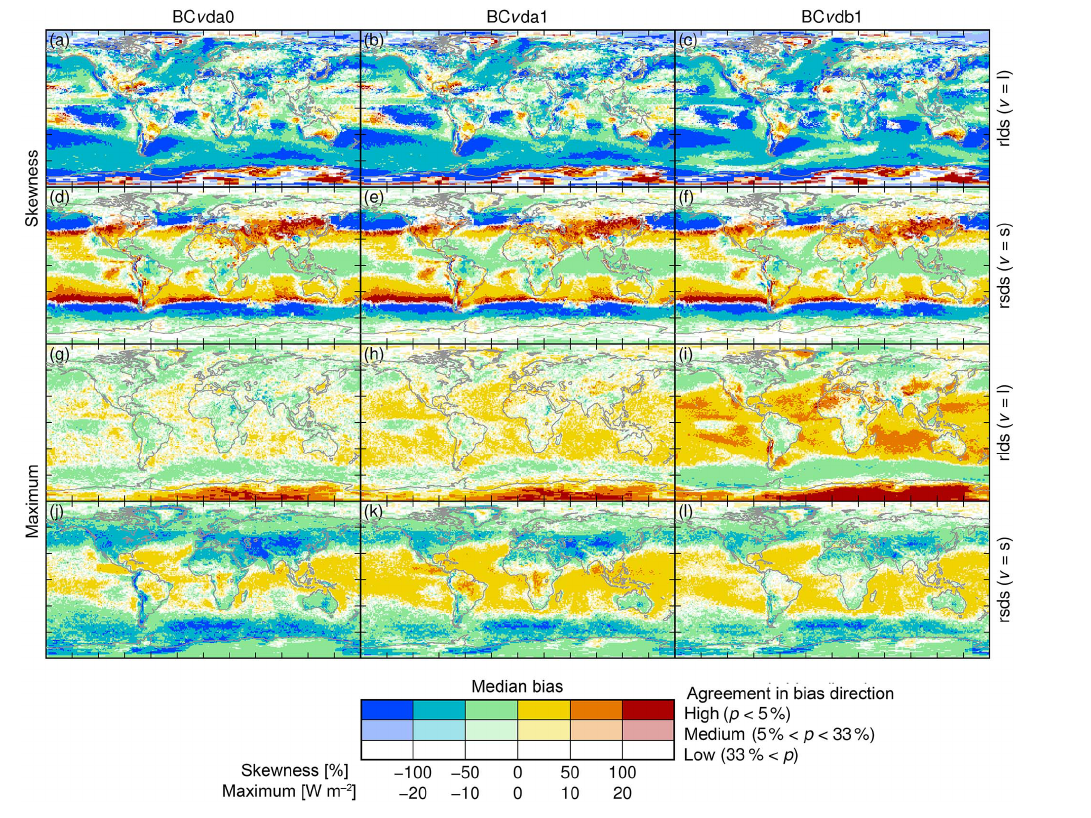
Figure 3. Same as Fig. 2 but for biases in skewness ( a – f ) and 12-year maximum values ( g – l ).